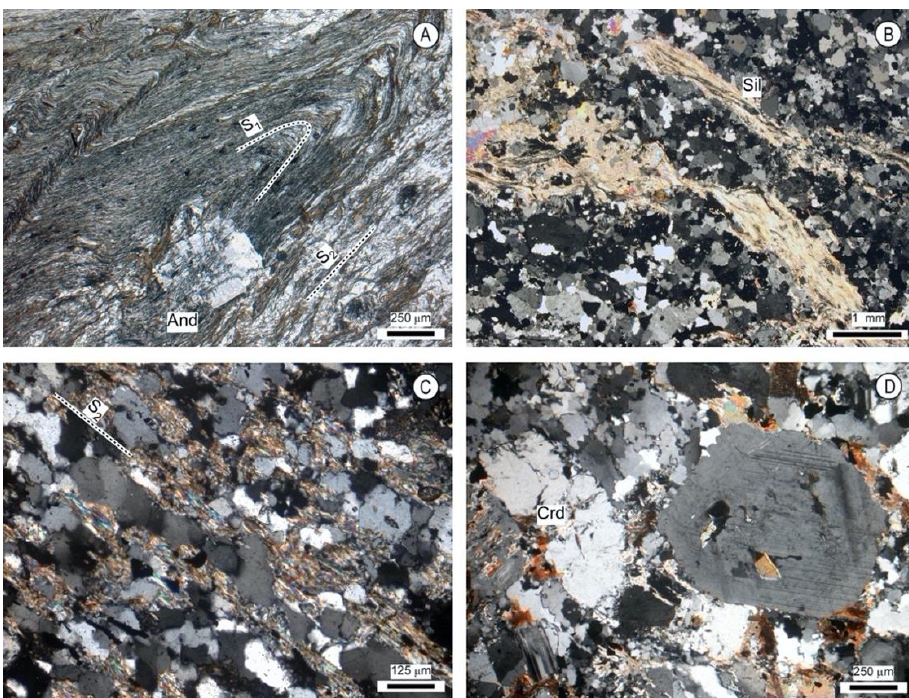
Figure 3. Textural photomicrographs of the analysed samples. ( A ) Detail of relations in schists between the S 2 parallel to the axial plane of microfolds that deform an older S 1 -schistosity. The schis- tosity is defined by quartz biotite and graphite. Idioblastic porphyroblast of andalusite (And) growth on S 2 . Plane-polarized light (sample tb-2009-7). ( B ) Polymineralic sillimanite (Sil) flakes and parallel arrangement of quartz and plagioclase in the sample tb-07-845 from the Istan migmatites. Crossed polars. ( C ) Microscopic fabric of sample tb-18-06, a quartzite interlayered with marbles, showing a penetrative schistosity, S 2 , marked by the preferred orientation of recrystallized grains of quartz and muscovite. Crossed polars. ( D ) Idioblastic porphyroblast of plagioclase with inclusions of garnet and biotite. Cordierite (Crd) porphyroblasts and mosaic textures in recrystallized quartz indicate a high temperature deformation of sample Gu-35-2 (Hoyo del Bote migmatite). Crossed polars.